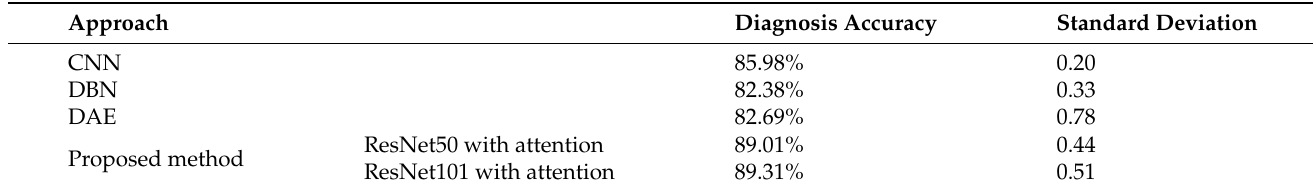
Table 9. Test performance of different